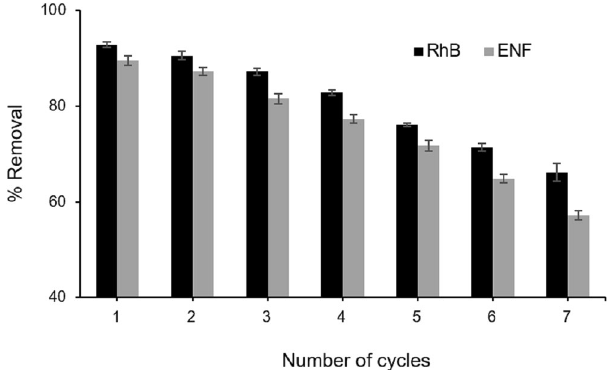
Fig. 4 Effect of regeneration cycles on the removal of ENF and RhB. Removal conditions: adsorbent amount: 0.24 g, RhB concentra- tion: 10 mg L − 1 , ENF concentration: 10 mg L − 1 , sonication time: 23 min, and pH: 7. Error bars represent standard